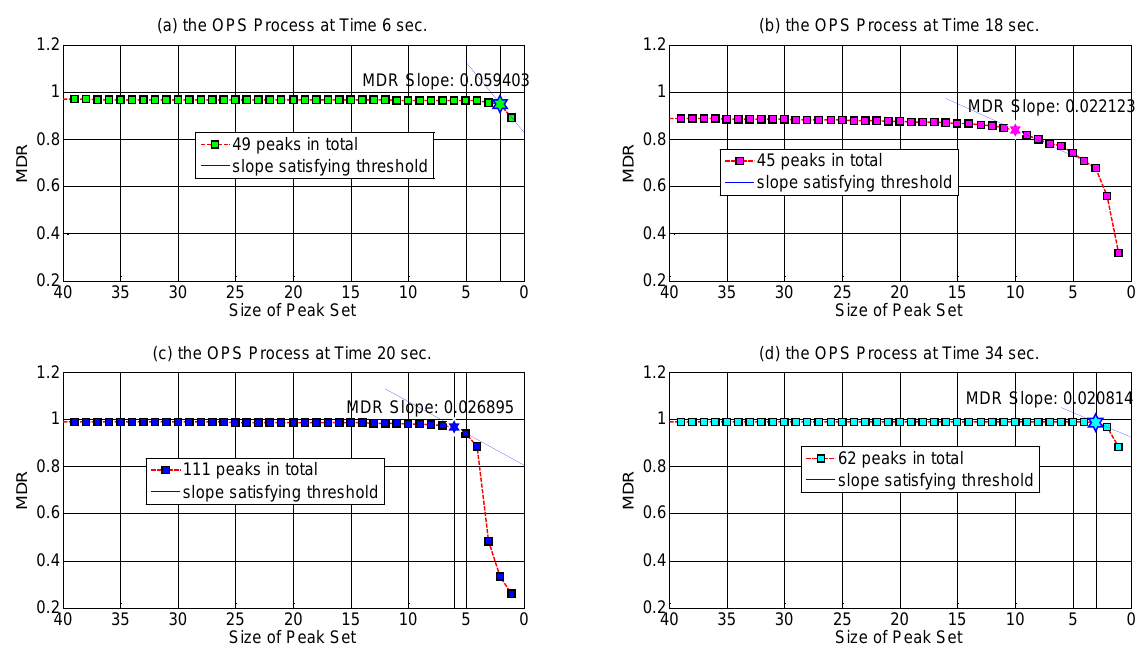
Figure 3. The MDR values for differently sized candidate peak sets ( r values less than